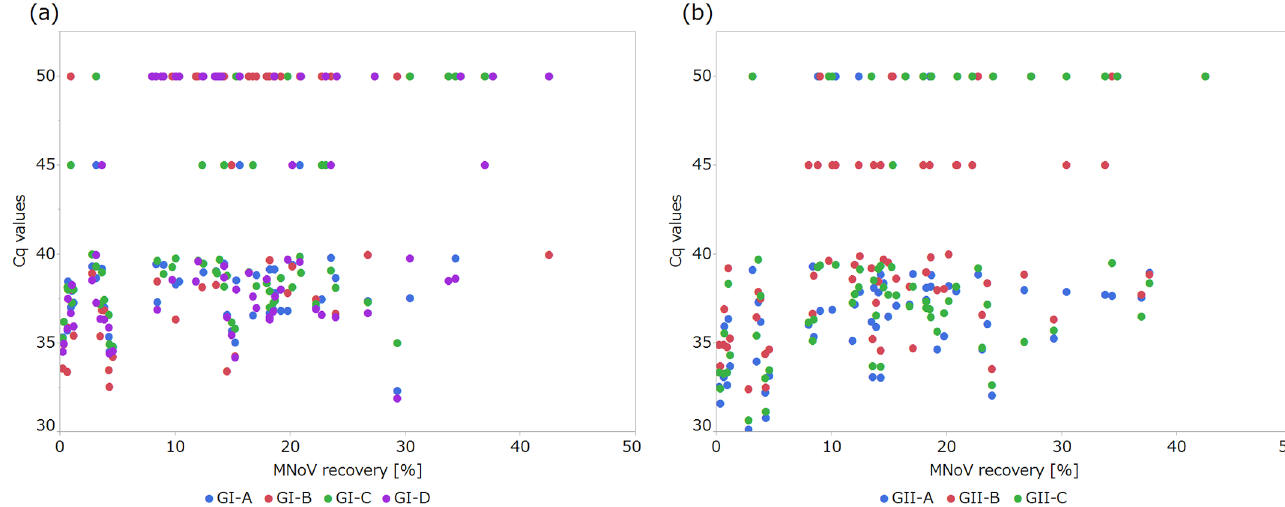
Fig 2. Recovery rates of spiked murine norovirus and Cq values from qPCR targeting the norovirus GI (a) and GII (b). Plots at Cq = 45 and 50 show positive but not quantifiable samples (original Cq > 40) and negative samples, respectively.